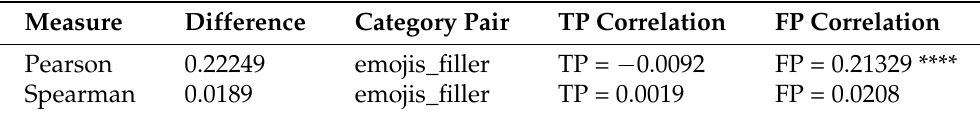
Table 10. Emojis and Fillers in